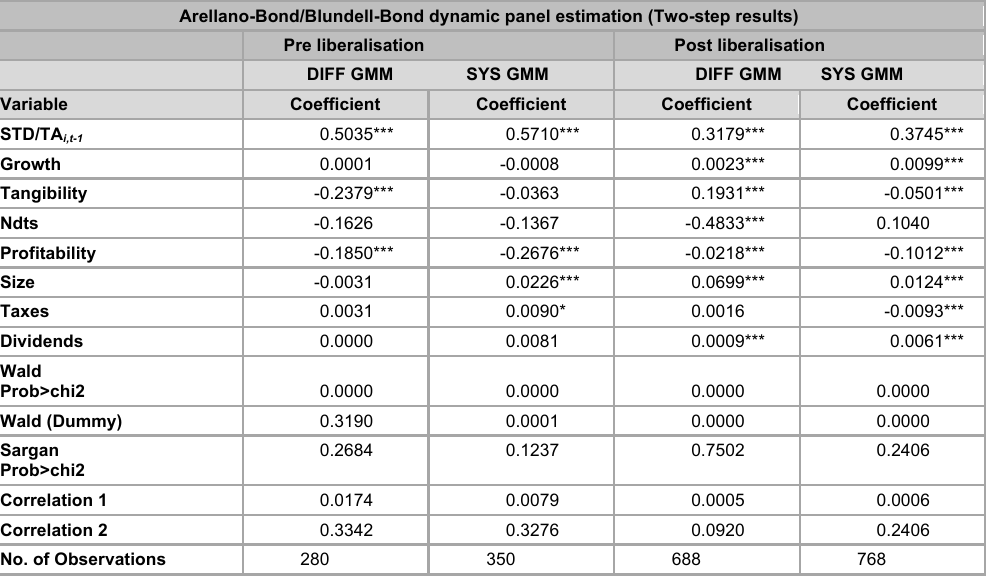
GMM estimates of target capital structure (short term debt